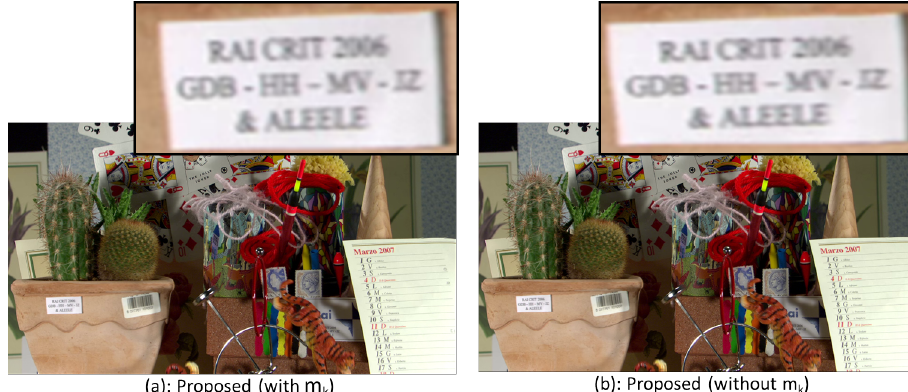
Figure 9. Visual comparison of the proposed